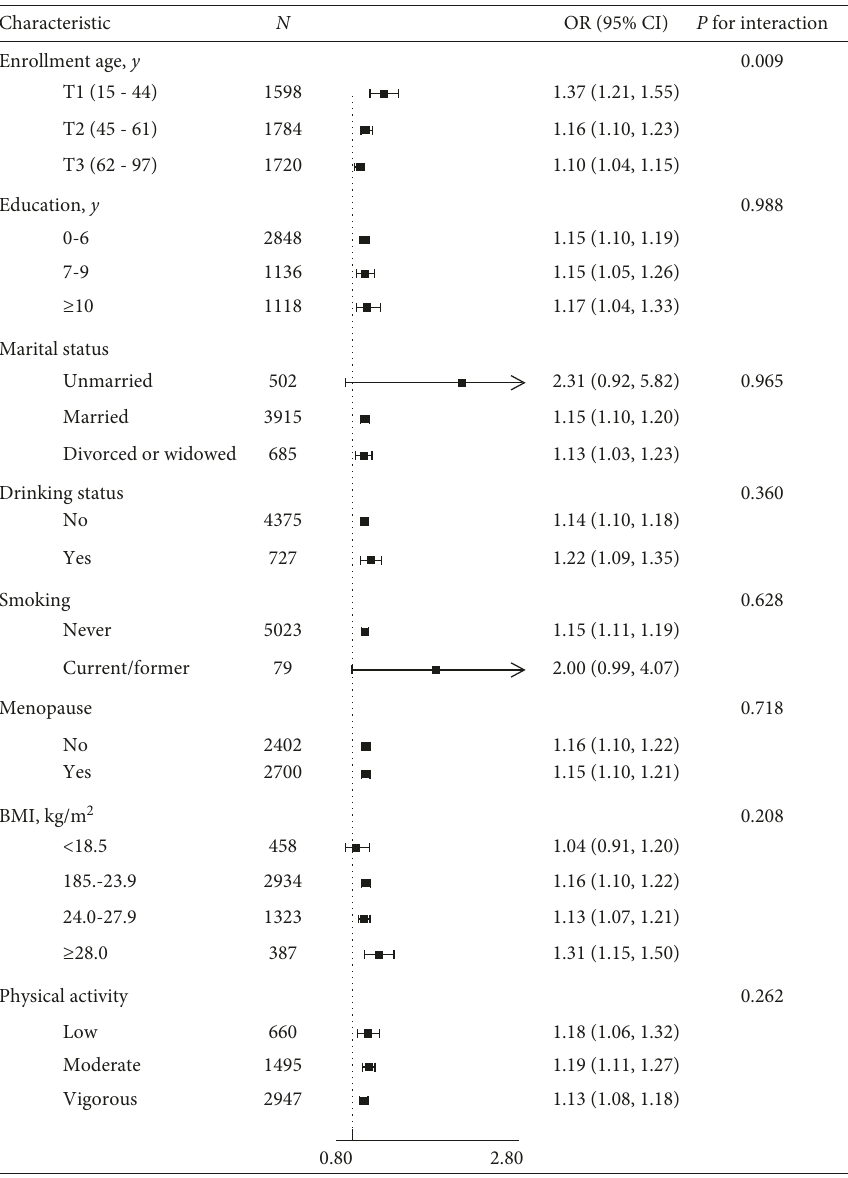
Figure 3: Effect size of AAM on hypertension in each subgroup. Adjusted, if not stratified, for enrollment age, residence, education, marital status, smoking, drinking, menopause, antihypertensive medication, physical activity, BMI, WC, BFP, VAI, BMR, HR, and sleeping